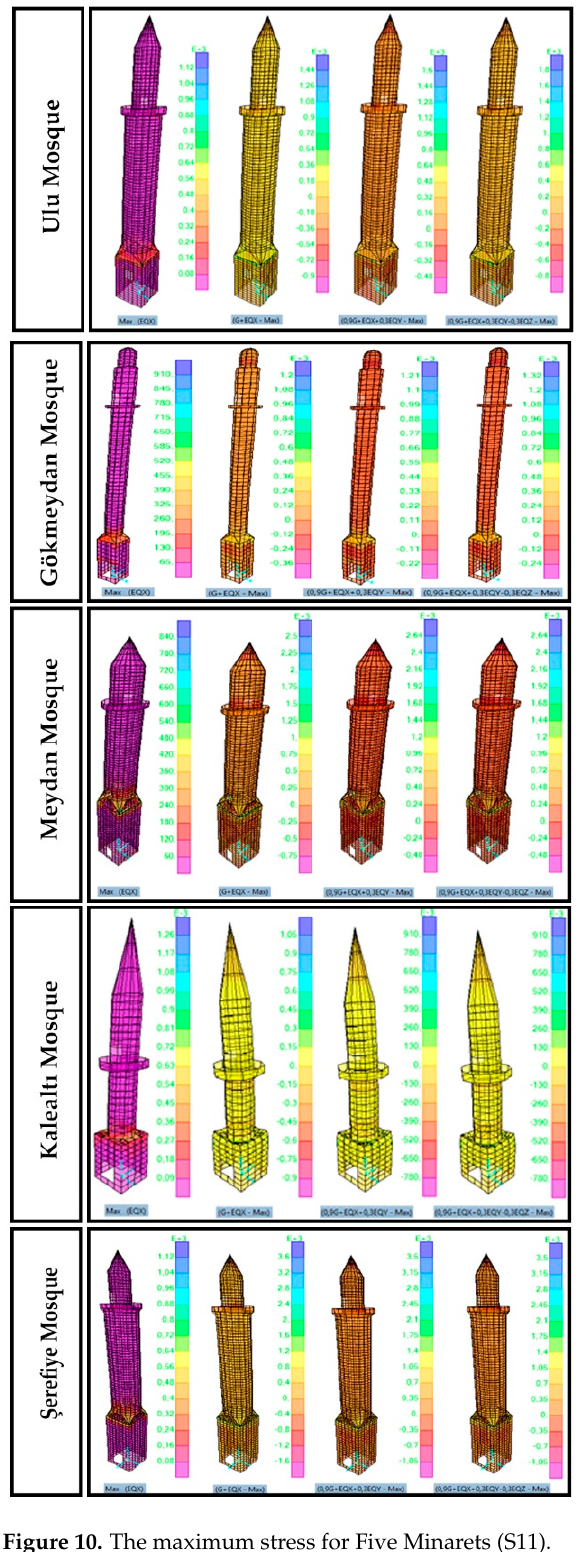
Figure 10. The maximum stress for Five Minarets (S11). The maximum stress diagrams for the vertical stress in the y-direction (S22) obtained from different load combinations are shown in Figure 11.